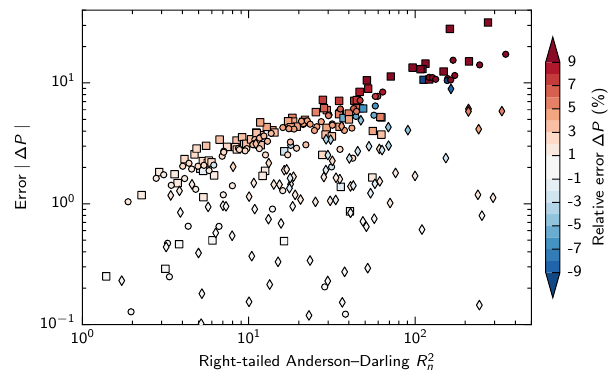
Figure 6. Relative error in the wind power production, (cid:49)P (in ab- solute value) as a function of the right-tail Anderson–Darling score, R 2 n , used as a goodness-of-fit estimate for the Weibull distribution. The distribution is fit by the maximum likelihood (squares), mo- ments (circles) and WAsP (diamonds) methods at each station. Log- arithmic